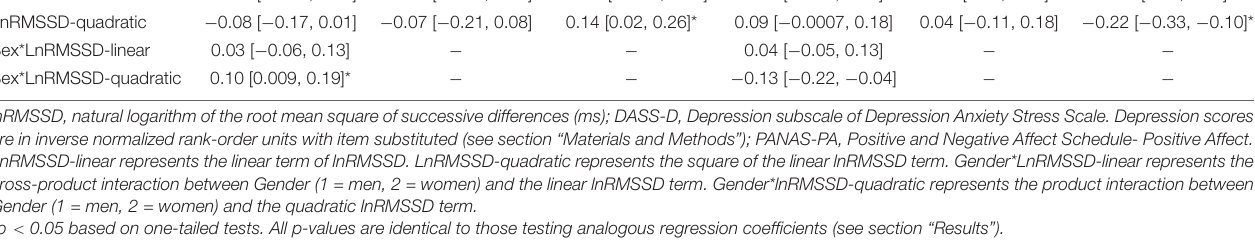
TABLE 2 | Partial Pearson correlation coefficients [95% CI] representing relationships between vmHRV and emotional outcomes. DV: DASS-depression DV: PANAS-positive affect Entire sample Men Entire